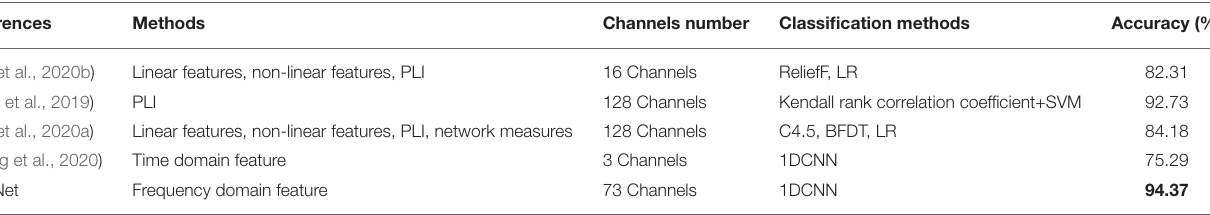
TABLE 5 | The confounding matrix and evaluation index are used to compare the classification results of SparNet and correlation methods in the same data